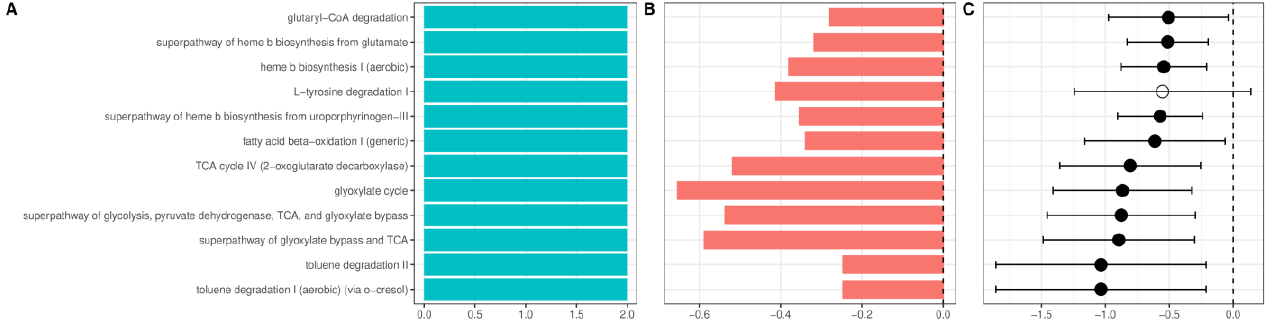
Figure 7. Changes in the relative abundance of the inferred metagenomic pathways between patients with alcohol use disorder and healthy controls ( A ). Number of datasets in which given pathway was detected as significant. ( B ). Change in the relative abundance of a given pathway in the combined dataset reported as log-ratio. Blue denotes bacteria more abundant in healthy controls, and red more abundant in alcohol use disorder. ( C ). Change in the relative abundance of a given pathway after summarizing results from individual datasets using the random-effects model, expressed as a mean difference in centered log ratios. Values larger than zero denote greater abundance in healthy controls. A full dot denotes a statistically significant effect. Error bars indicate 95% confidence intervals. Only pathways detected as significant in at least two datasets or significant in random-effects analysis are presented.